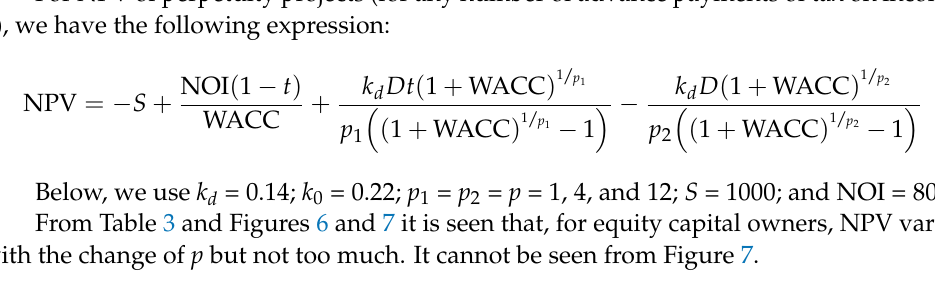
Table 3. Change of net present value, NPV, with leverage, L , for k d = 0.14, k 0 = 0.22, and p = 1, 4, and 12.